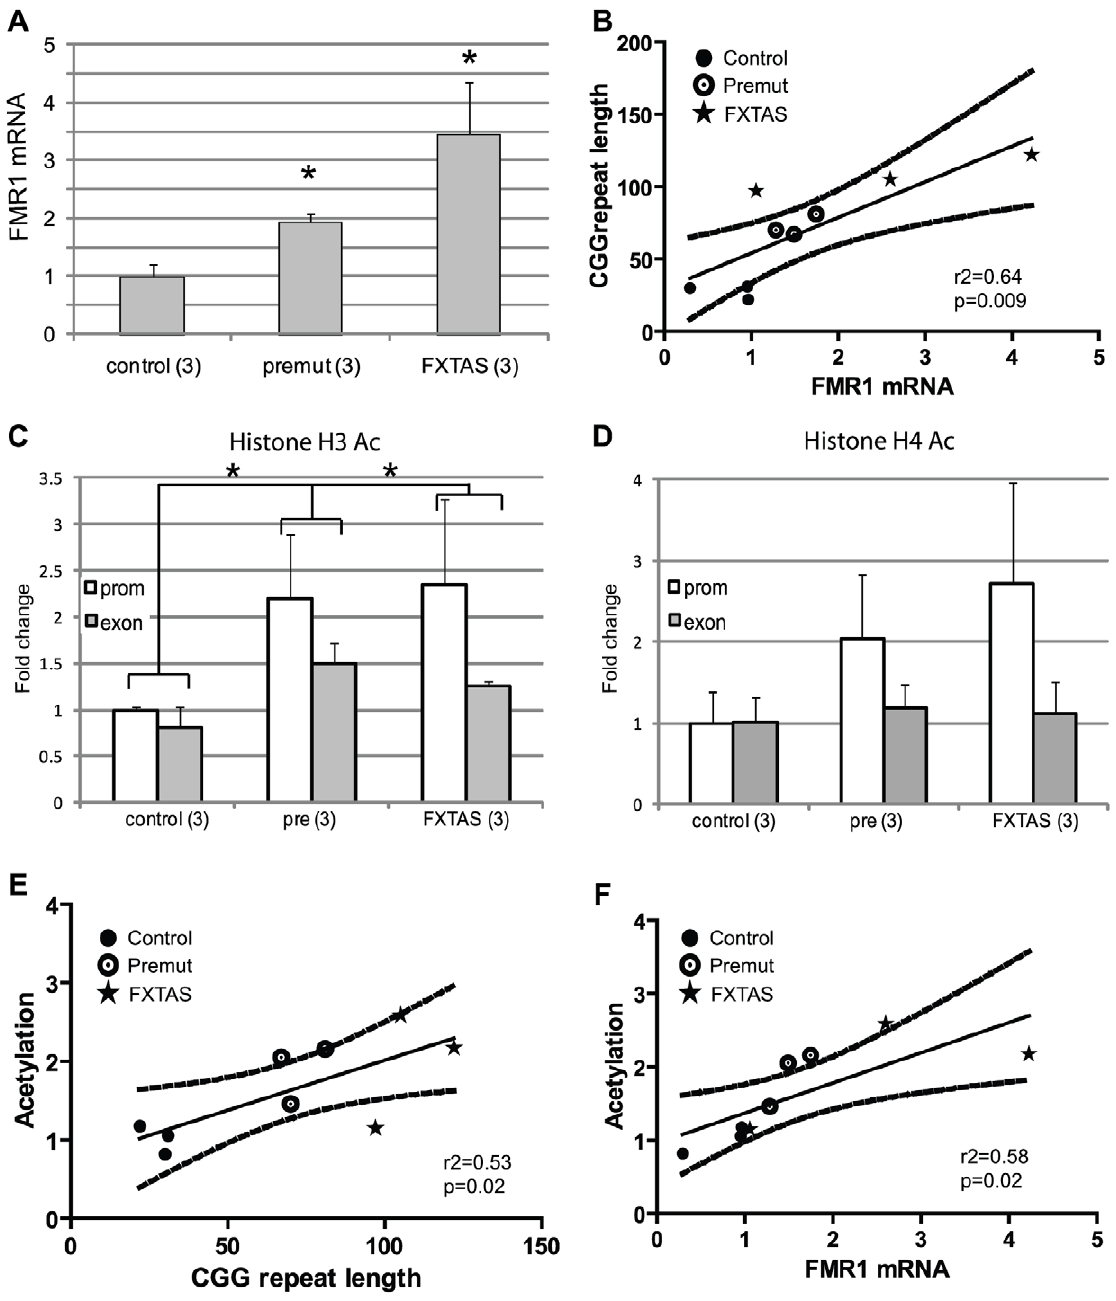
Figure 5. Chromatin alterations at the FMR1 locus in FXTAS patient derived fibroblasts. A) FMR1 mRNA expression in fibroblast cell lines quantified by qRT-PCR, normalized to actin and expressed as fold change from the mean of 3 control cell lines. We used 3 control cell lines (C1(CGG) 31 , C4(CGG) 22 and C5(CGG) 30 ) 3 asymptomatic pre-mutation carrier lines (P3(CGG) 81 , P4(CGG) 70 and P5(CGG) 67 ) and 3 cell lines from FXTAS patients (F1(CGG) 122 , F2(CGG 105 and F3(CGG) 97 ). *=p , 0.05 compared to controls. B) Correlation of CGG repeat length and FMR1 mRNA expression. Black dots represent controls, open circles represent asymptomatic pre-mutation carriers, stars represent FXTAS patient-derived cell lines. Straight line reflects best fit and curved lines represent 95% confidence intervals. The correlation is significant (r 2 =0.584, p=0.016). C) ChIP performed on fibroblasts using antibody to Acetylated H3K9. White bars represent primers directed against the FMR1 promoter, Gray bars against FMR1 exon 1. Results are normalized to mean value of the control cell lines and expressed as fold change from this cell line. *=p , 0.05 of averaged FMR1 levels from the promoter and exon versus controls. D) ChIP performed on fibroblasts using an antibody directed against Acetylated Histone H4. Pooled analysis grouping of all pre-mutation carrier-derived cell lines was significant for either AcH3K9 alone or a pooled analysis of both (AcH3K9, p=0.02; AcH4 + AcH3K9, p=0.008), unpaired Students t-test). E) Correlation of CGG repeat number to histone acetylation (r 2 =0.44, p=0.05). F) Correlation of FMR1 mRNA expression and histone acetylation at the FMR1 locus was significant (r 2 =0.582, p=0.016). Data from individual cell line ChIP experiments are shown in Figure S6.